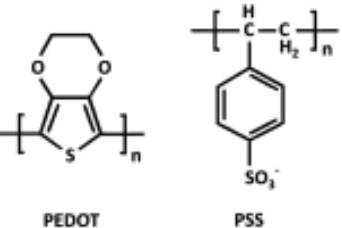
Figure 1. Chemical structures of Poly(3,4-ethylenedioxythiophene) (PEDOT) and Poly(sodium 4-styrenesulfonate)